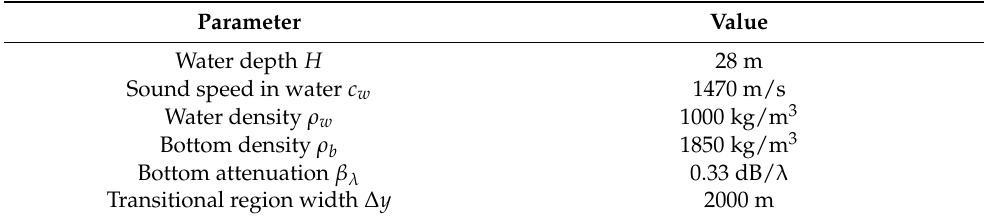
Figure 1. Simplified waveguide model demonstrating the sound speed structure c b ( x , y , z ) in a transitional region between an acoustically soft and hard bottom; black circle depicts the location of a sound source. Table 1. Waveguide